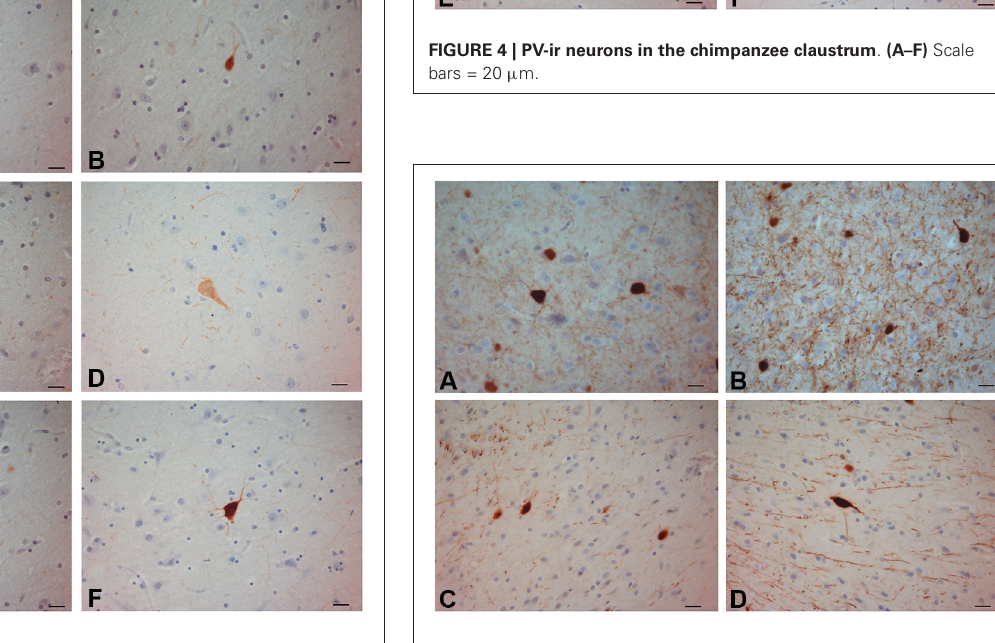
FIGURE 3 | PV-ir neurons in the human claustrum . (A–F) Scale bars = 20 µ m.